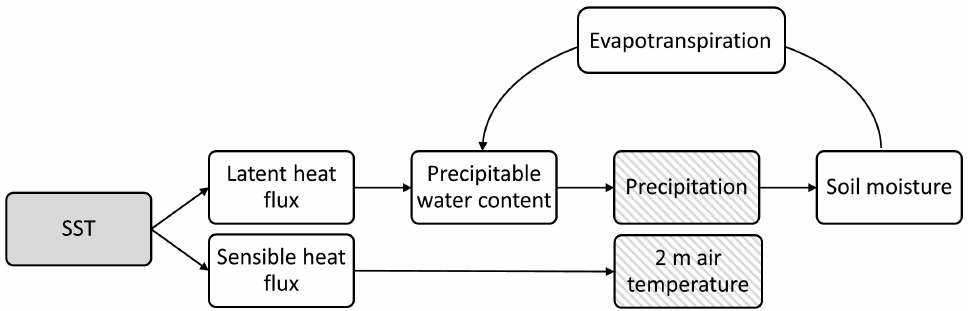
Figure 6. Positive feedback mechanism between precipitation, soil moisture and